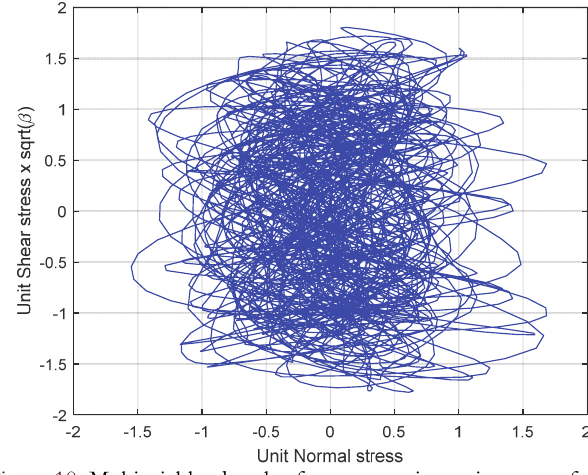
Figure 10: Multiaxial load path of a twenty minute time trace from a three hour realization depicted in the 3   stress space whilst considering a stress amplitude ratio of